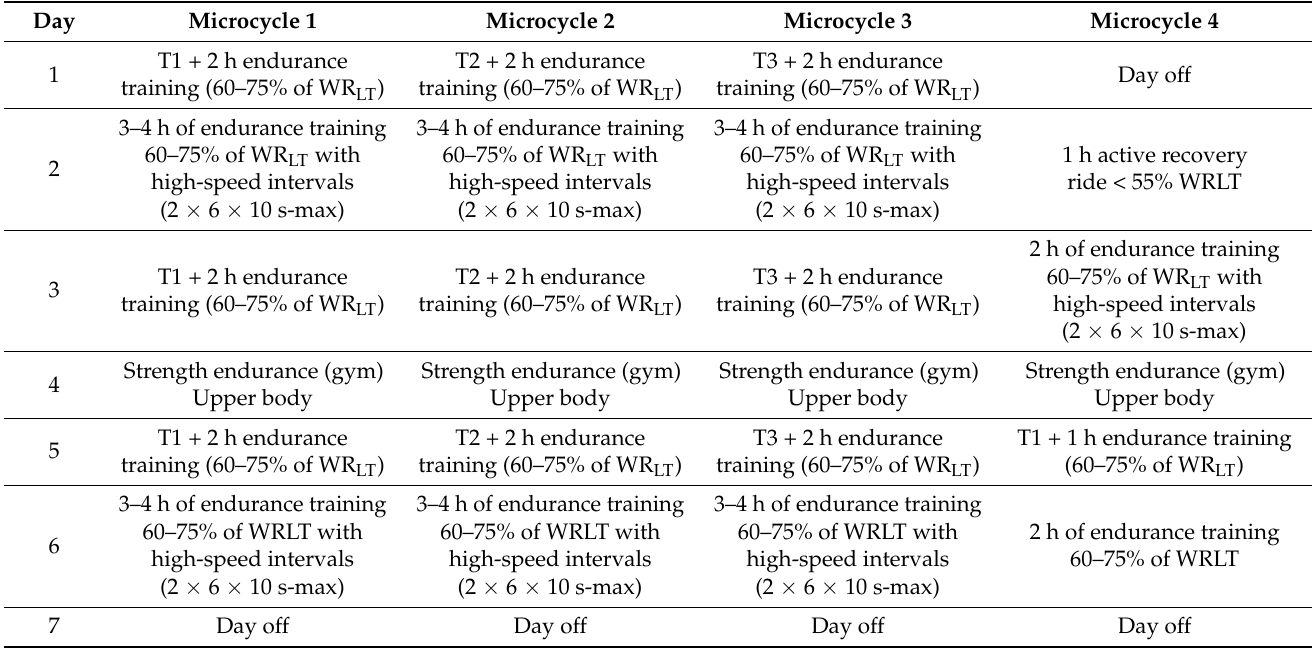
Table 2. Training program during the